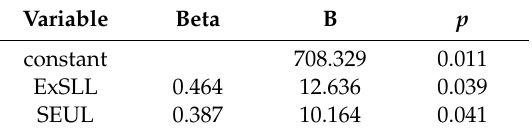
Table 4. Summary of ridge regression for all participants (Y5-Total; R 2 =